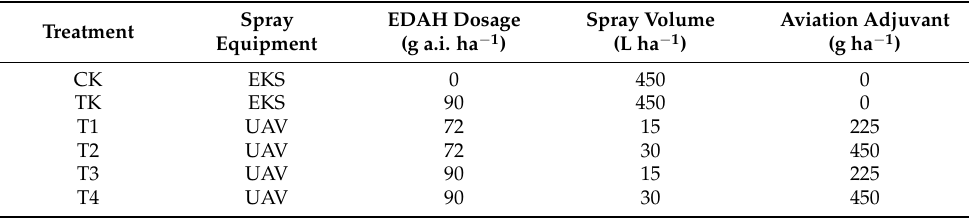
Table 1. Experimental treatments from 10 June to 5 October in 2019 and 2020. Treatment